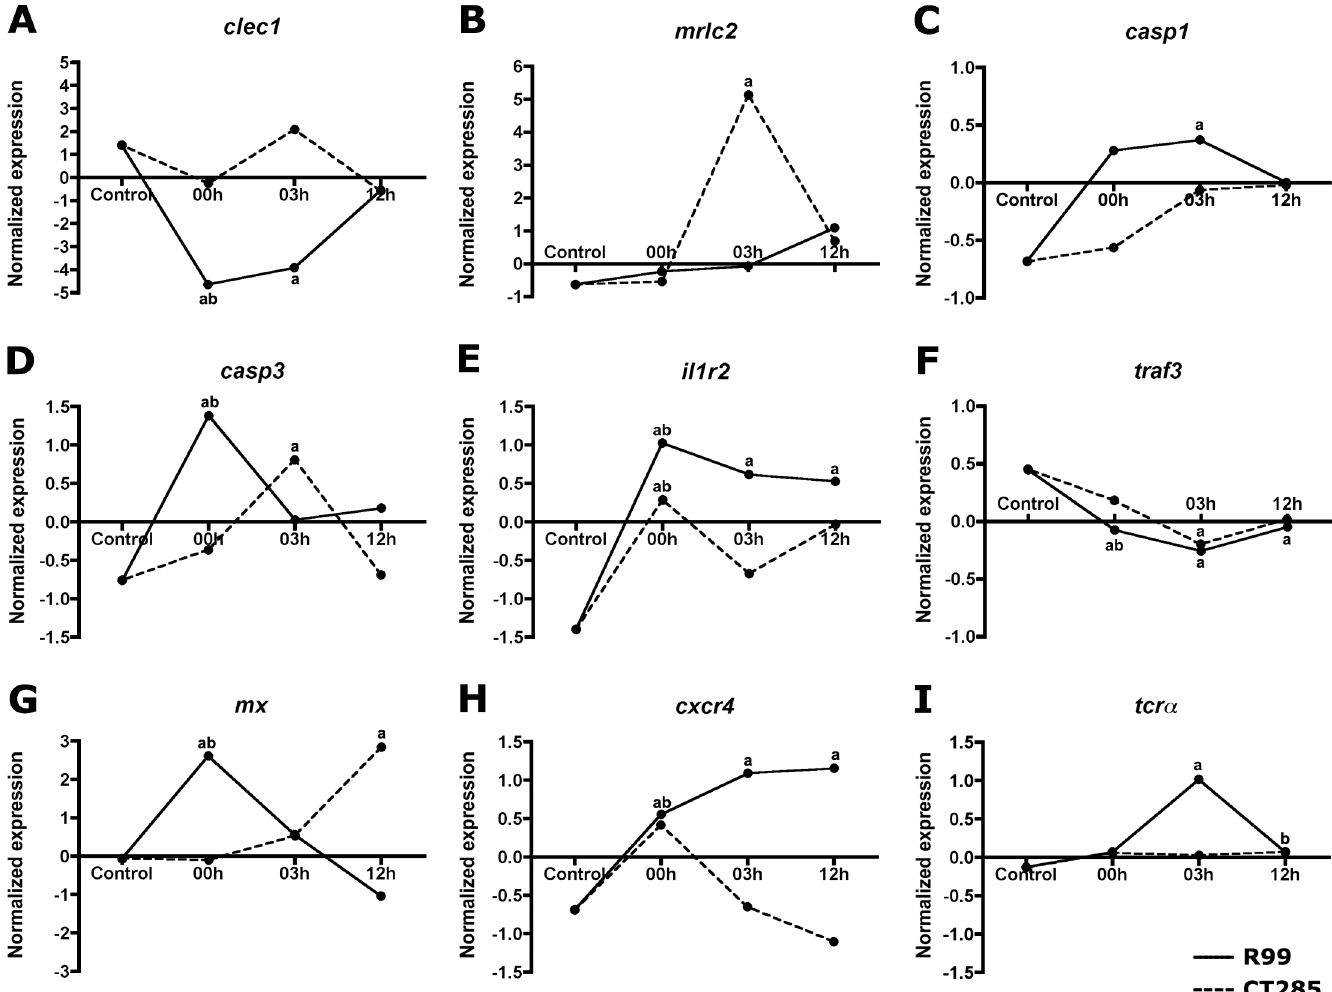
Fig 4. Detailed representation of most relevant up and downregulated transcripts by mean normalized array expression, corresponding to (A) C- type lectin 1 ( clec1 ), (B) to Myosin regulatory light chain 2 ( mrlc2 ), (C) to Caspase-1 ( casp1 ), (D) to Caspase-3 ( casp3 ), (E) to Interleukin 1 receptor type 2 ( il1r2 ), (F) to TNF receptor-associated factor 3 adaptor ( traf3 ), (G) to Myxovirus resistance ( mx ), (H) to CXC chemokine receptor type 4 ( cxcr4 ) and (I) to T-cell receptor V alpha ( tcr α ). Continuous line represents R99 infection and discontinuous line the CT285 infection. a represents statistical significance (p < 0.05) relative to HC; and b statistic significance of p < 0.05 by loop